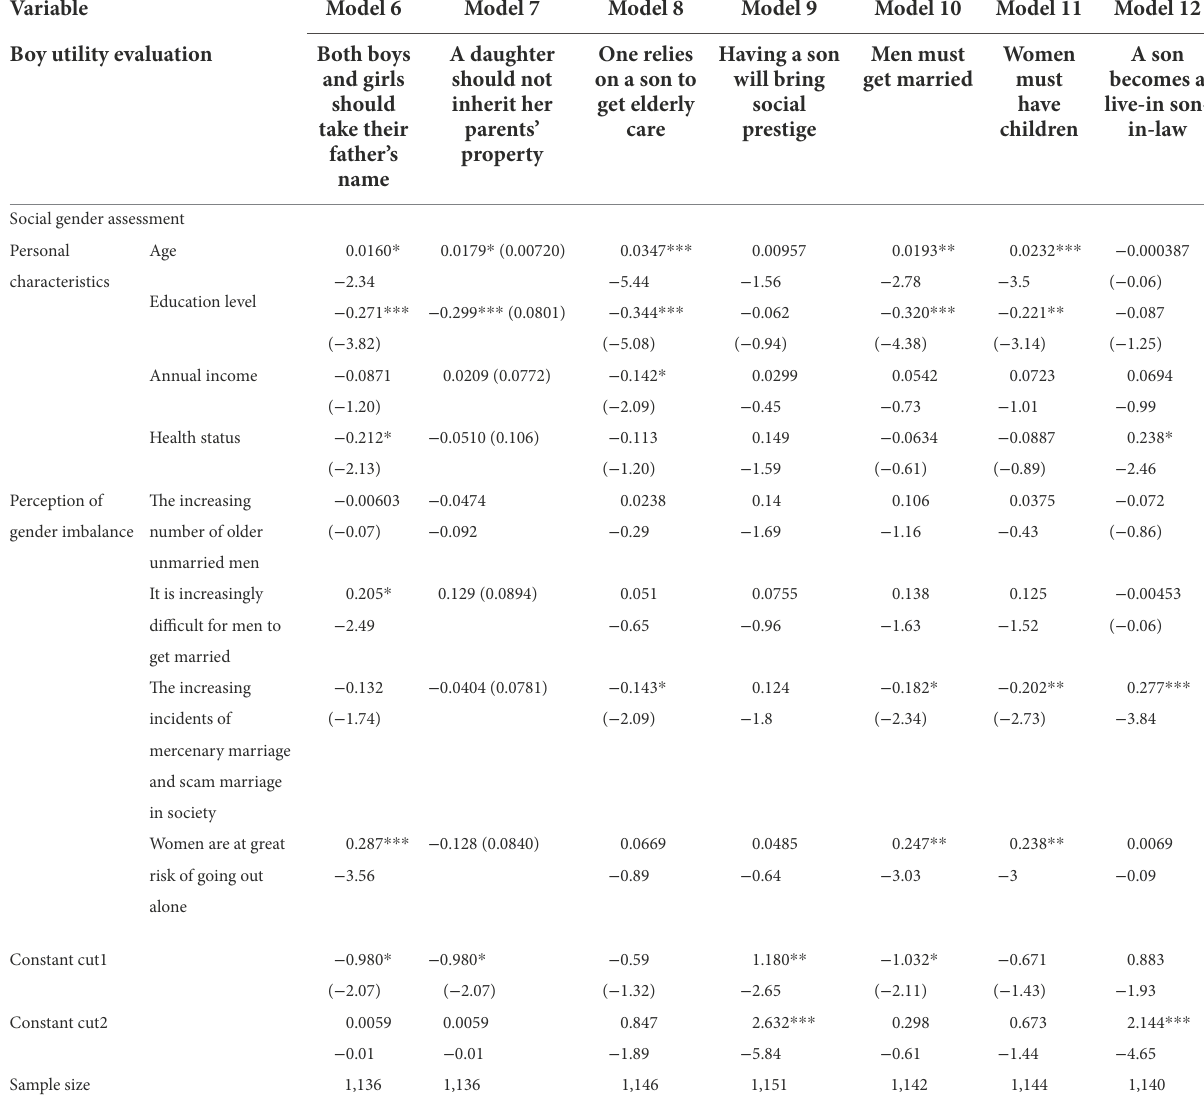
TABLE 4 Correlation of gender imbalance perception with boy utility evaluation and social gender assessment.